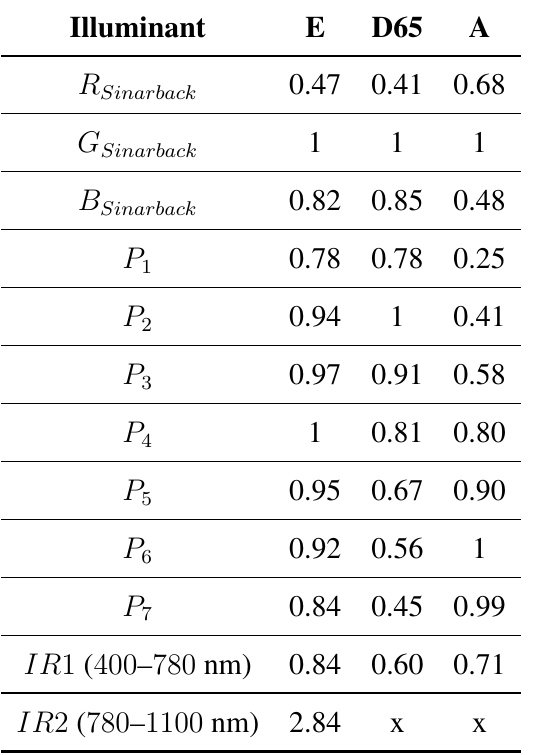
Table 3. Relative normalized values of the sensor response ( ρ illuminant and a perfect